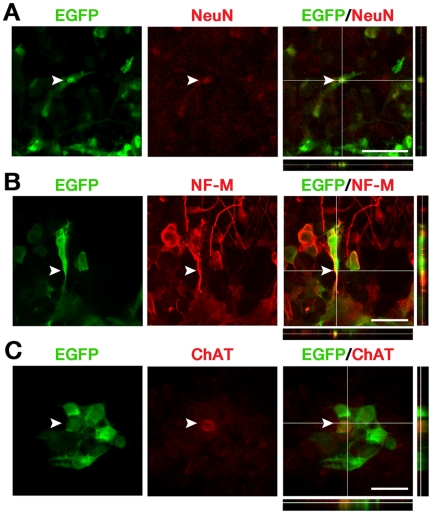
MNIM-EOH cells express mature neuronal/MN markers after transplanted into the injured spinal cord slice culture.Confocal microscopy analysis of MNIM-EOH cells (green) immunostained with anti-NeuN (red) (A), anti-NF-M (red) (B), and anti-ChAT (red) (C) antibodies. In the slices, 37 of 472 EGFP+ cells were NeuN+, 20 of 316 EGFP+ cells were NF-M+, and 14 of 469 EGFP+ cells were ChAT+. Colocalization of EGFP and NeuN, NF-M, or ChAT in a single cell was confirmed by z-axis stack analysis. At least 4 slices were analyzed. Scale bars: 50 µm.